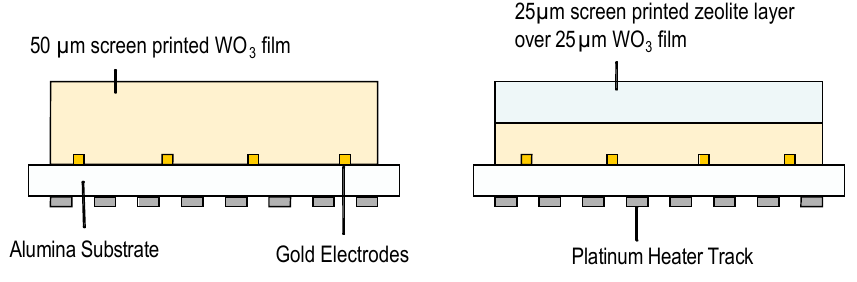
Platinum Heater TrackGold ElectrodesAlumina